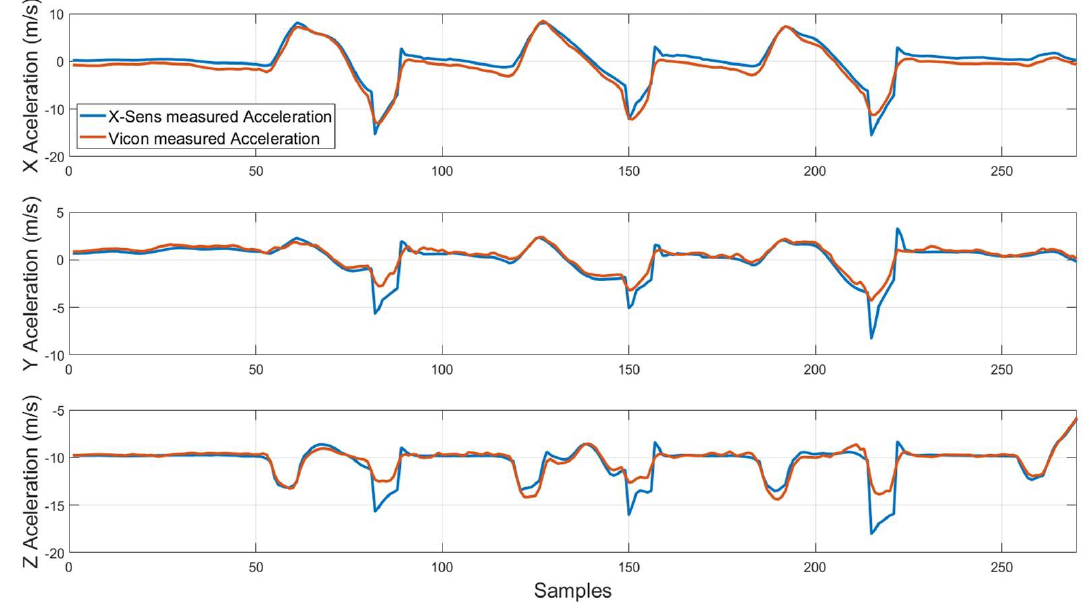
Figure 6. Comparison of acceleration measured by X-Sens and